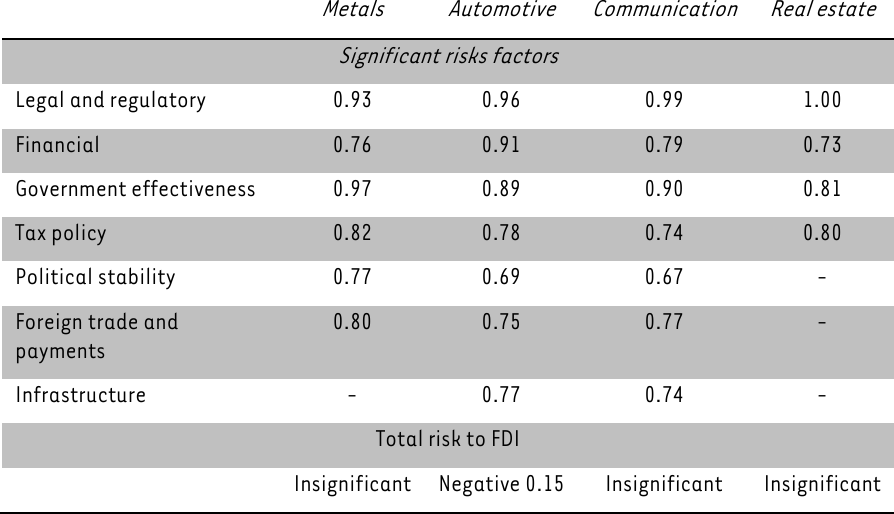
TABLE 4: Factors analysis: significant risk factors